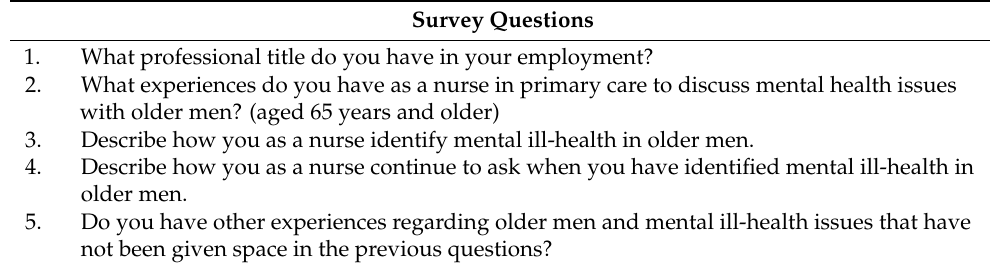
Table 2. Survey questions about the nurses’ experiences identifying mental ill-health in older